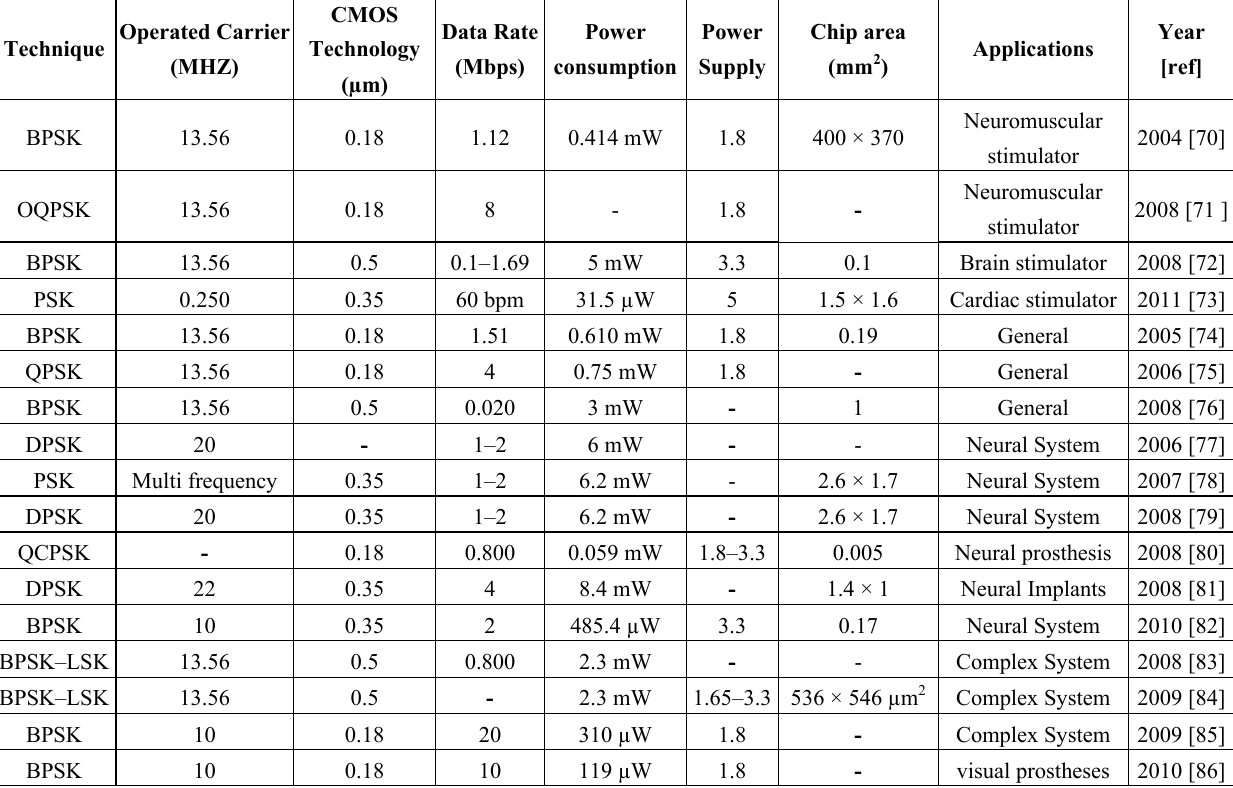
Table A3. PSK modulations used in telemetric wireless and implanted